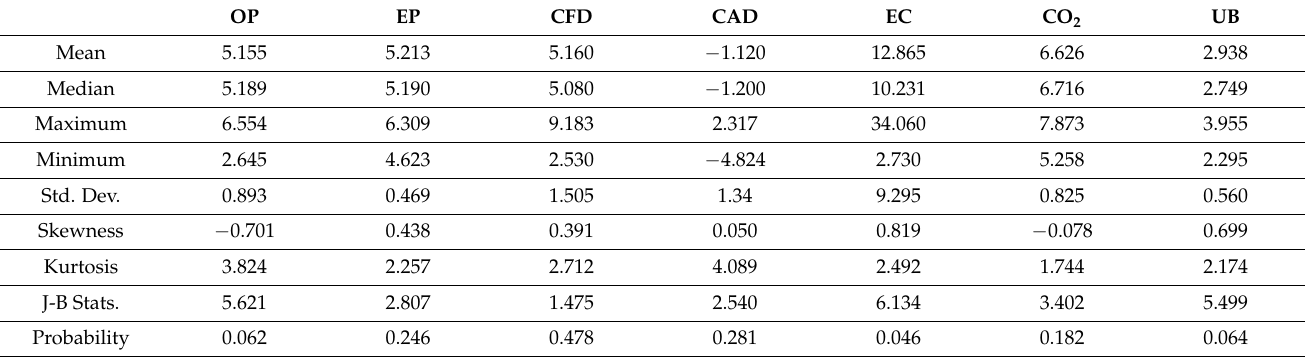
Table 2. Descriptive statistics.